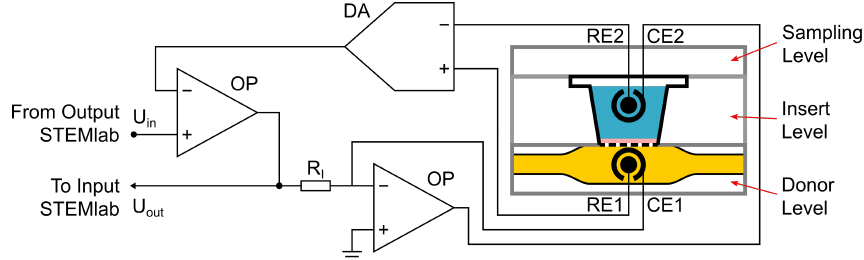
Figure 2. Electronic circuit of the potentiostat used for automated TEER measurements in connection to the microfluidic device. OP = operational amplifier; DA = differential amplifier; R I = shunt resistor; CE = current electrode; RE = reference electrode.